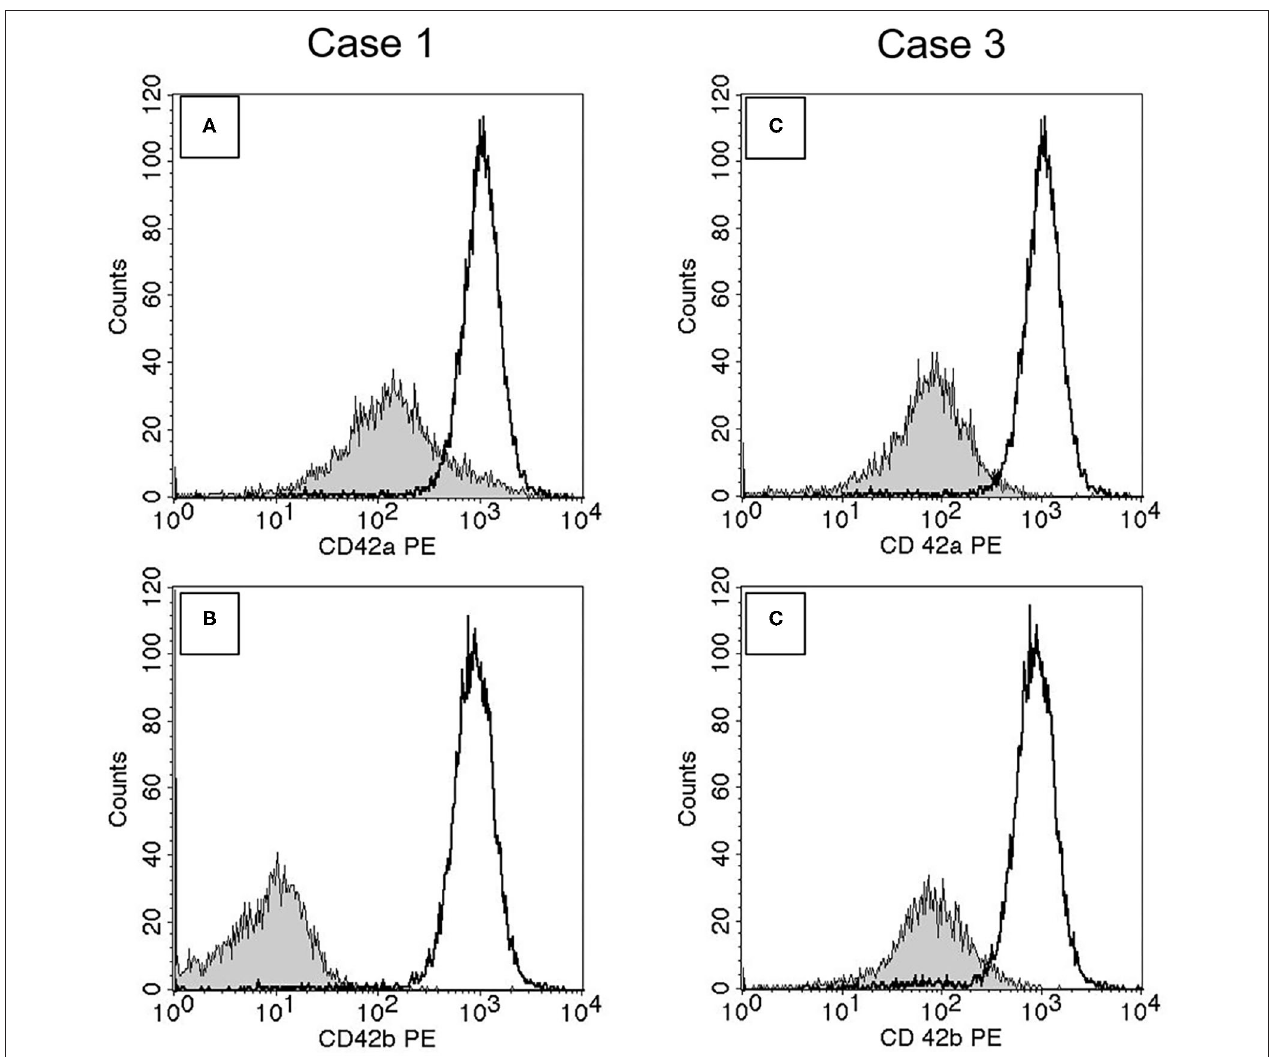
FIGURE 3 | Flow cytometry of the index cases of the two families: Plots (A) CD42a and (B) CD42b in Case 1; (C) CD42a and (D) CD42b in Case 3. The histograms of the cases and the same control are overlayed. The shaded area represents the histogram of the index case, the open area of the